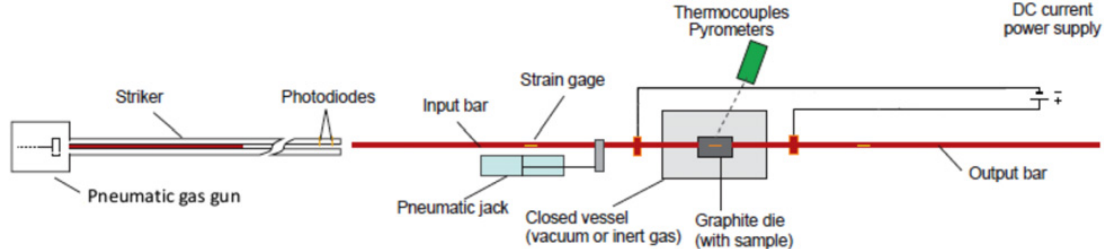
Fig. 1. Sketch of the DCRS device developed for dynamic